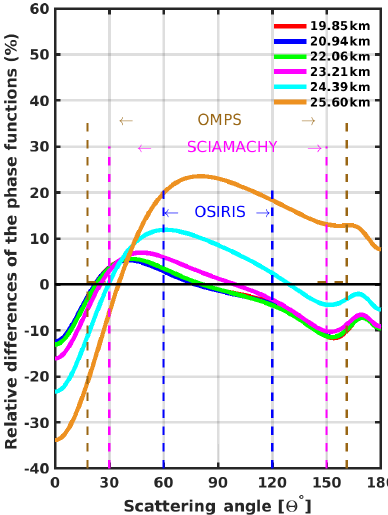
Figure 9. Relative differences between the phase functions derived from the gamma and the UMLN parameters fitted to the CARMA model data at each of the six altitudes from 19.85 to